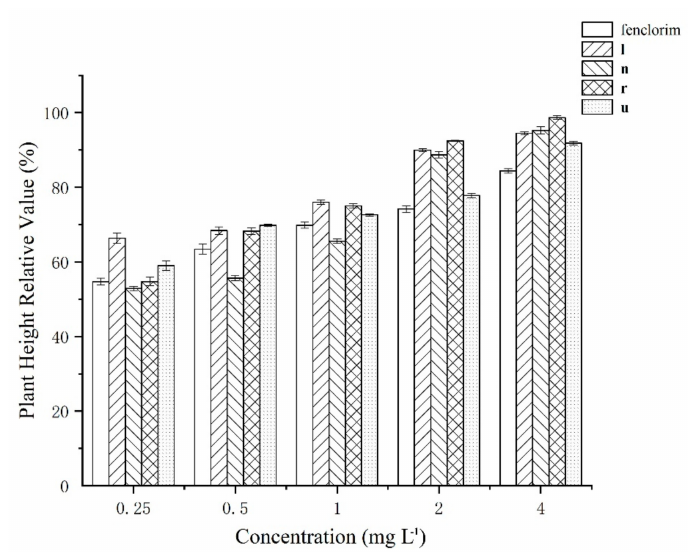
Figure 2. Plant height relative values of 0.25 µ M metolachlor ( M )-treated rice plants treated with